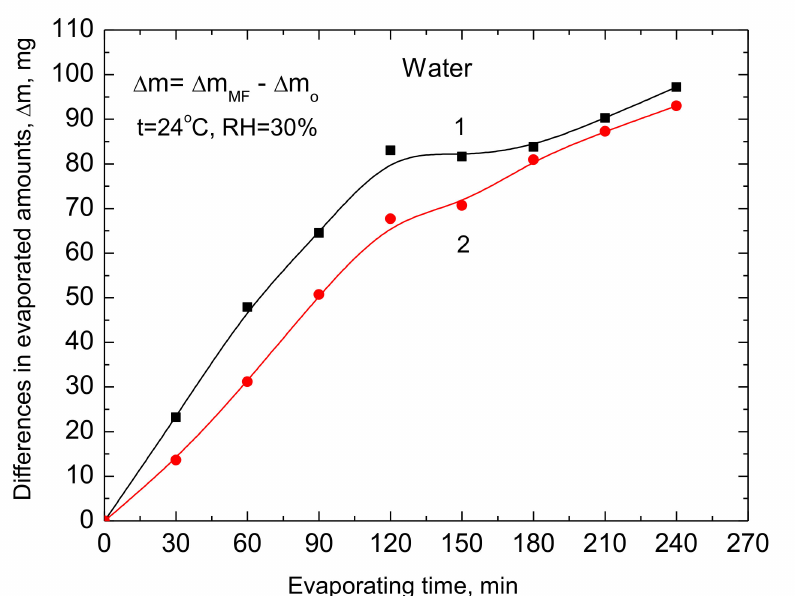
Figure 7. Differences between the evaporated water from one of the MF-treated samples and two reference untreated samples calculated individually. The evaporation experiment was conducted simultaneously using the three